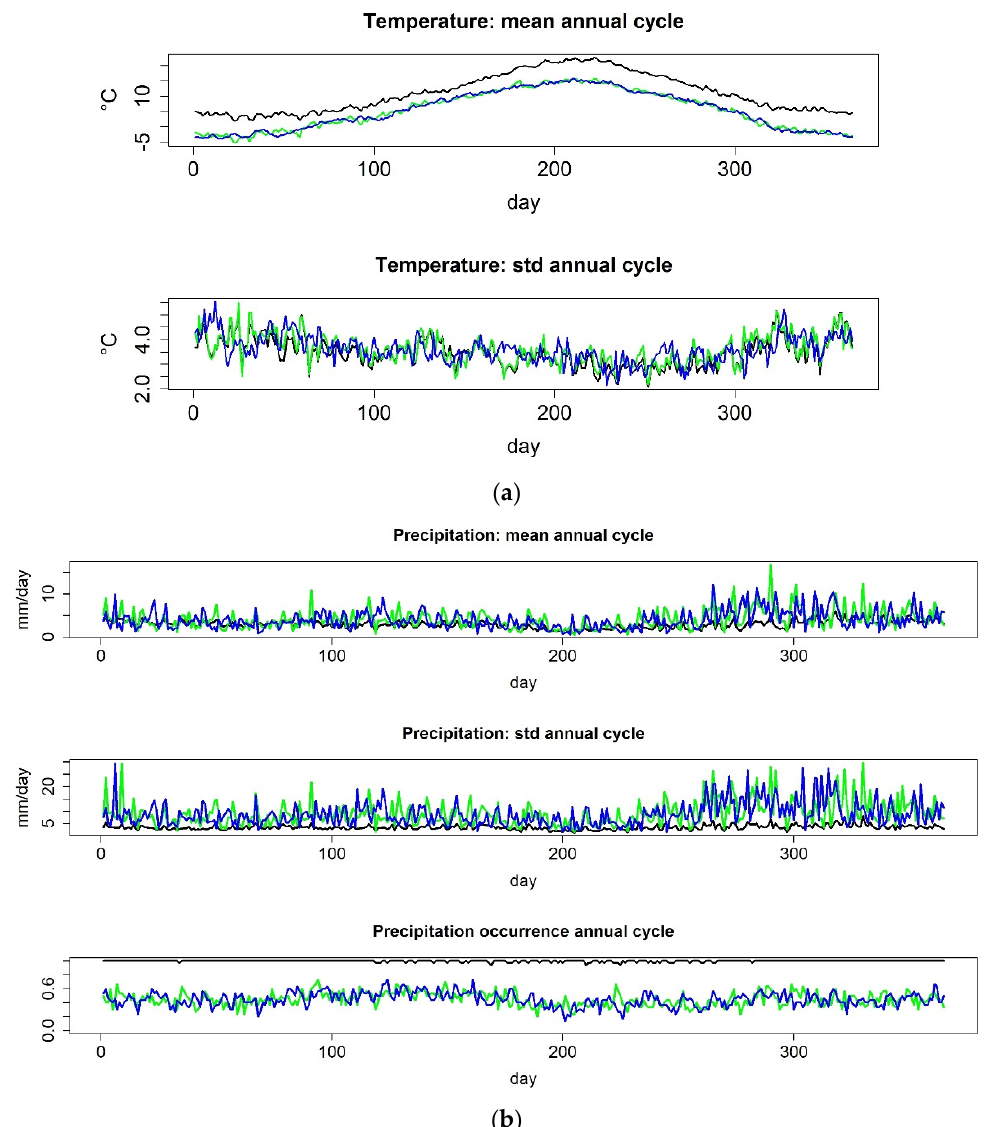
Figure 5. ( a ) mean and standard deviation annual cycles of temperature over period 1976–2005 given by the raw climate projection (black), the observations (blue) and the bias adjusted-climate projection (green). ( b ) same as ( a ) but for precipitation, with the addition of the annual cycle of the proportion of rainy days.